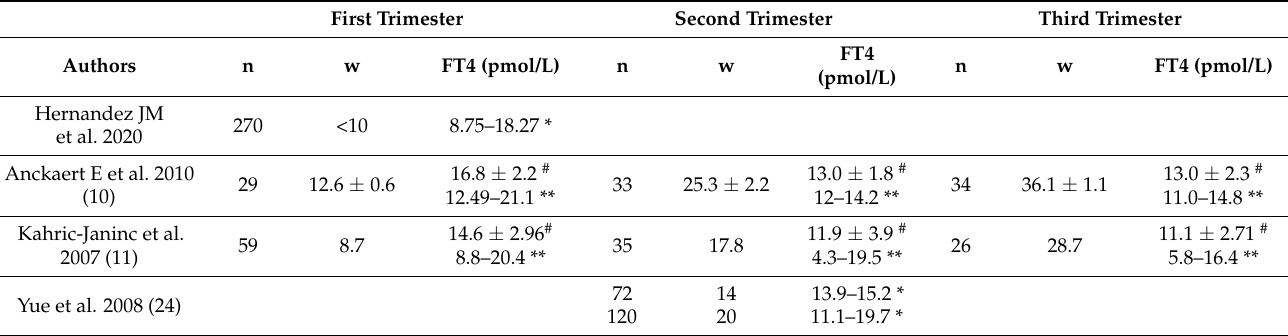
Figure 1. Correlations between free thyroxine concentrations measured by two immunoassays and liquid chromatogra- phy/tandem mass spectrometry. Table 3. Reference intervals of free thyroxine measured by liquid chromatography/tandem mass spectrometry published by different